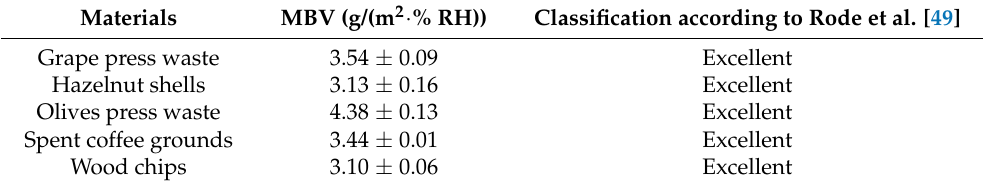
Table 7. MBV of analysed bio-wastes classified according to Rode et al. [49].